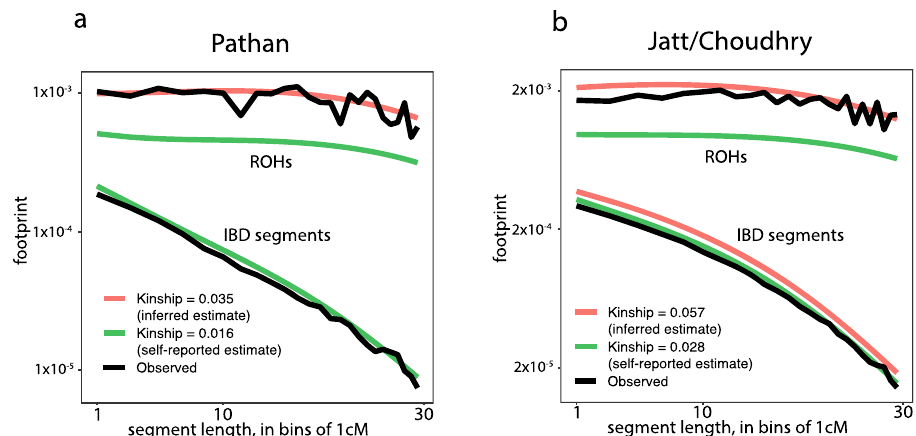
Fig. 5 Observed ROH and IBD footprints compared to the expectation under a coalescent model 54 . The footprint is the average fraction of the genome covered by segments of a given length interval. The top lines represent the ROH footprint and the bottom lines the IBD footprint. Points are plotted at the beginning of each 1 cM interval. The N e pro fi le used to compute the expected footprints was determined by IBDNe using a the Pathan from fi neSTRUCTURE ’ s Cluster 8 or b Jatt/Choudhry from Cluster 10. In a , for the IBD segments, the pink line is beneath the green one. We used kinship values calculated using either the self-reported relationships or the inferred estimates of consanguinity for the relevant group. The observed footprints (black lines) were determined using fi ltered IBD and ROH calls from IBDseq and bcftools/roh, respectively. Supplementary Fig. 16 shows equivalent plots using the upper and lower bounds of the 95% con fi dence interval for the IBDNe estimate as the N e trajectory, and using observed footprints from different ROH or IBD calling/ fi ltering strategies.